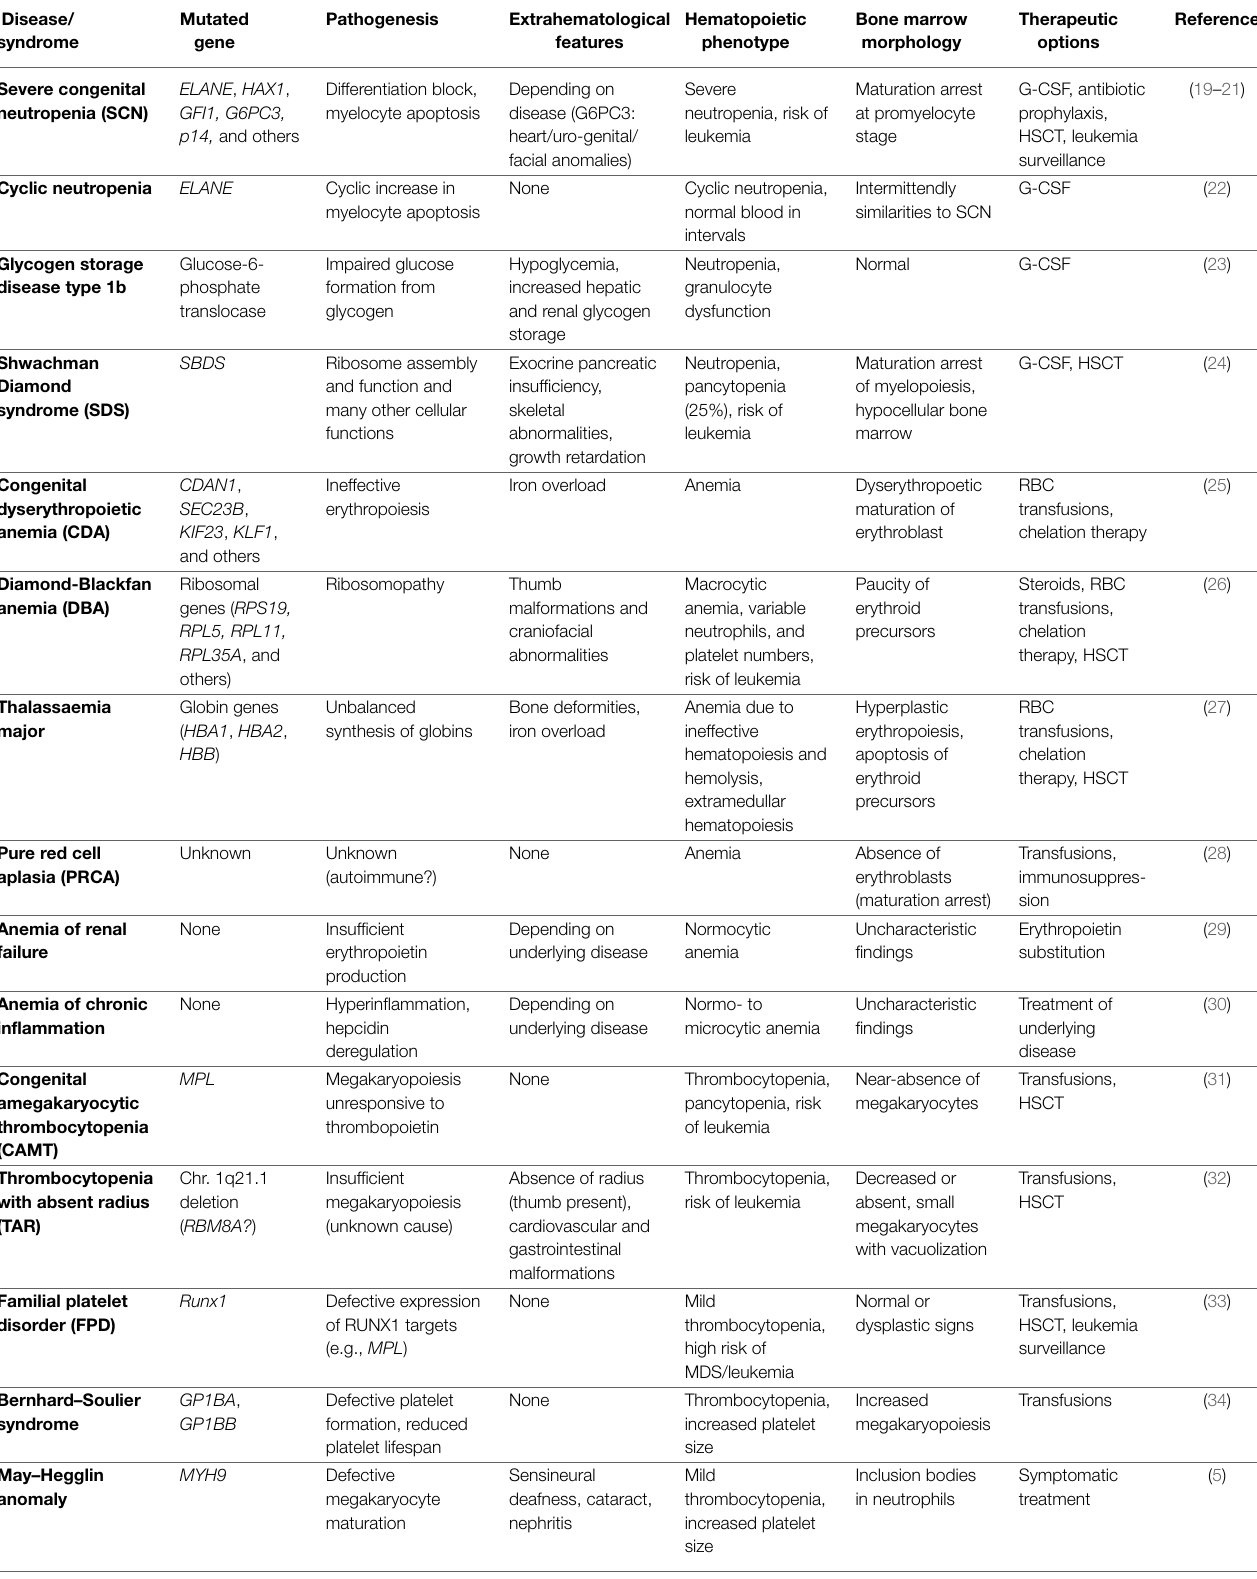
TABLE 1 | Syndromes characterized by inadequate formation of mature blood cells resulting in single lineage cytopenia